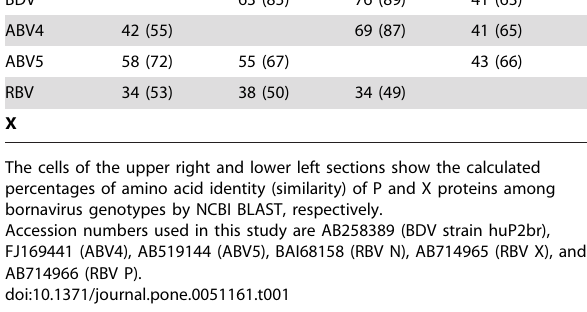
Table 1. Amino acid sequence homologies of X proteins and phosphoproteins among bornavirus genotypes.